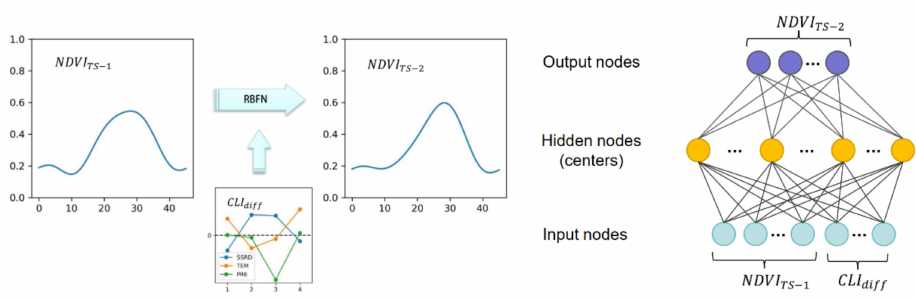
Figure 3. The structure of radial basis function networks (RBFNs) and the input and output